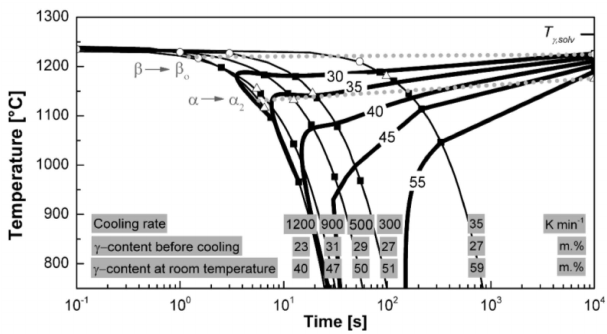
Figure 14. Continuous-cooling-transformation (CCT) diagram for the γ phase precipitation during the heat treatment of a TNM alloy. Broad black lines confine regions in which the given γ phase fraction (in m %) is certainly exceeded. The cooling paths plotted as narrow black lines result from the linear cooling rates of 35, 300, 500, 900 and 1200 K ¨ min ´ 1 , respectively. Thus, the influence of technologically relevant cooling rates on the quantitative gain in the γ phase can be derived [87]. Actual γ phase fractions (in m %) before and after cooling are indicated in the boxes at the bottom. (Reprinted from Reference [87], Copyright (2015), with permission from